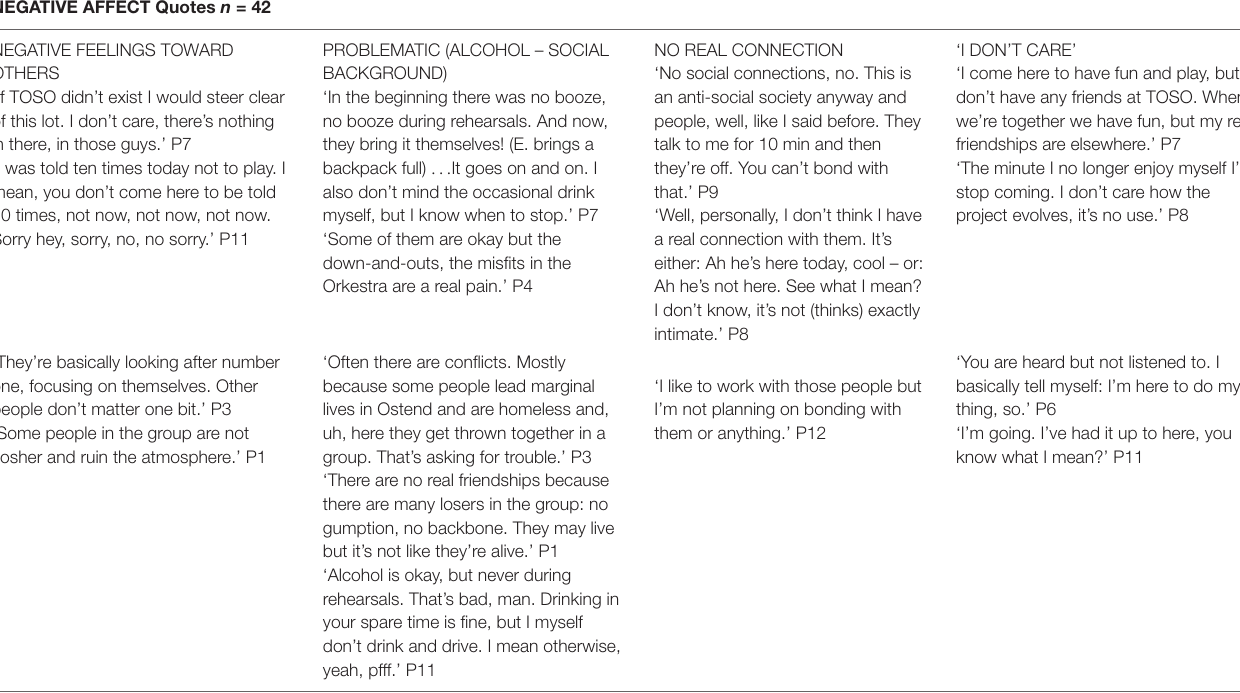
TABLE 2 | Negative affect. NEGATIVE AFFECT Quotes n =